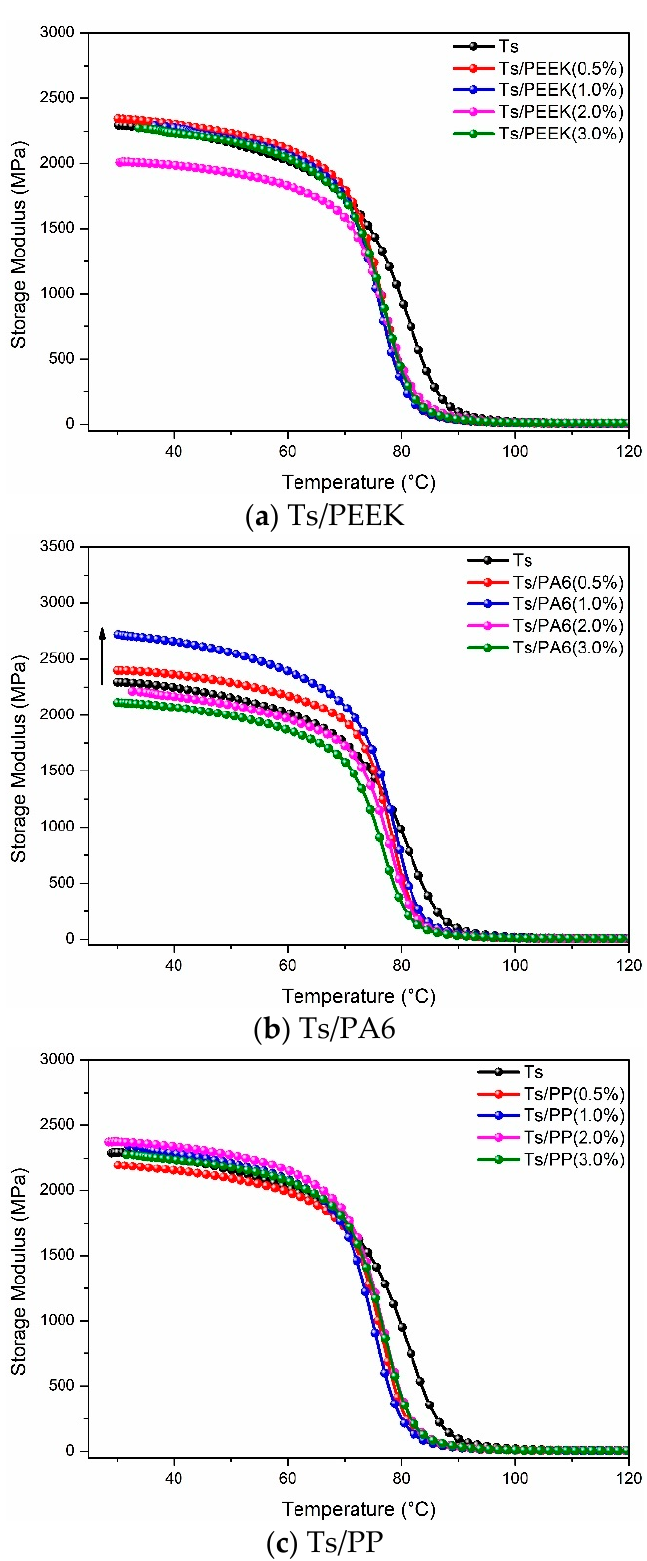
Figure 11. Effects of thermoplastic resin fillers on storage modulus of Ts resin of ( a ) Ts/PEEK, ( b ) Ts/PA6 and ( c ) Ts/PP.